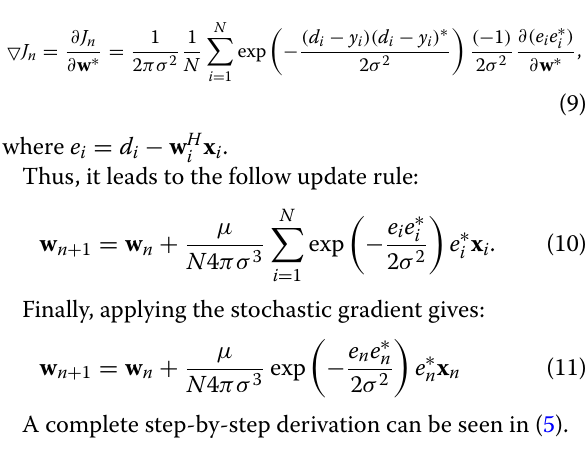
To obtain (cid:4) J n , the most obvious choice would be dif- ferentiating Eq. 4 with respect to w ∗ . However, Eq. 4 depends on complex-valued parameter ( d , y ) , although it is always a real-valued function when the complex Gaussian kernel from Eq. (2) is applied [15]. This violates the Cauchy-Riemann conditions, thus making the gradi- ent function not analytical in the complex domain